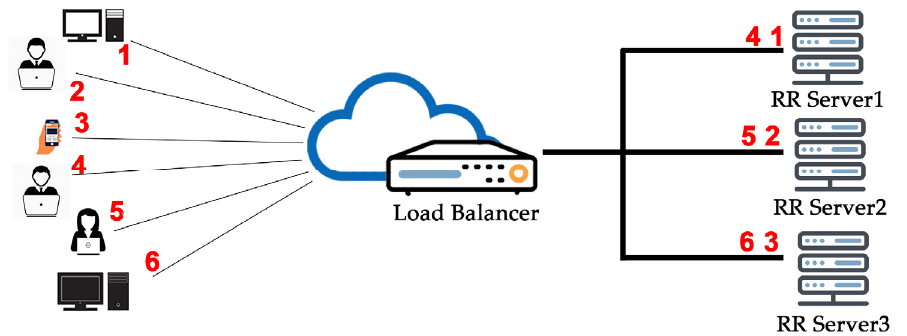
Figure 8. Model of the round robin algorithm.